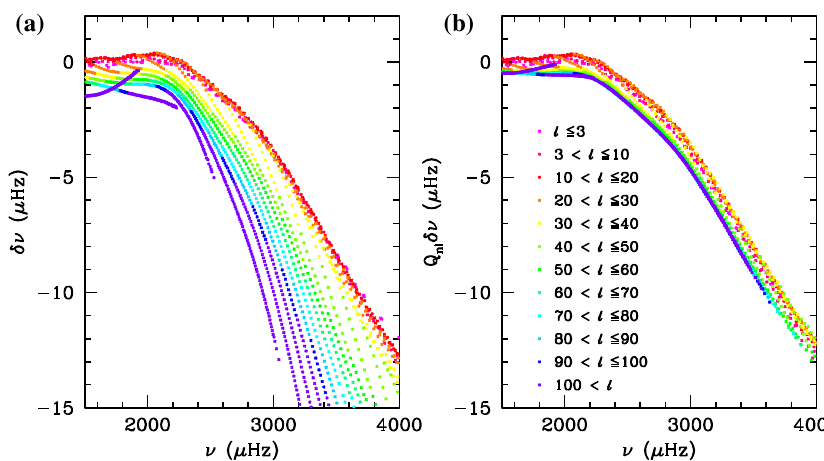
Fig. 4 The differences in frequencies of the Sun (mode set BiSON-13 of Basu et al. 2009) and that of standard solar model known as Model S (Christensen-Dalsgaard et al. 1996). a The raw frequency differences, b scaled differences, where the scaling factor Q n (cid:2) corrects for the fact that modes with lower inertia change more for a given perturbation compared to modes with higher